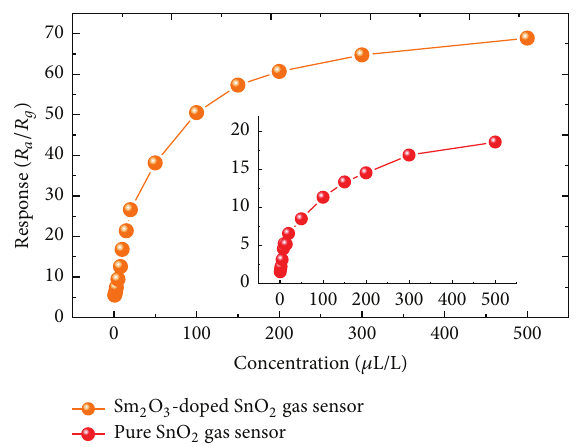
Figure 8: Gas responses of the sensors versus different concentra- tion of C 2 H 2 from 1 to 500 𝜇 L/L.